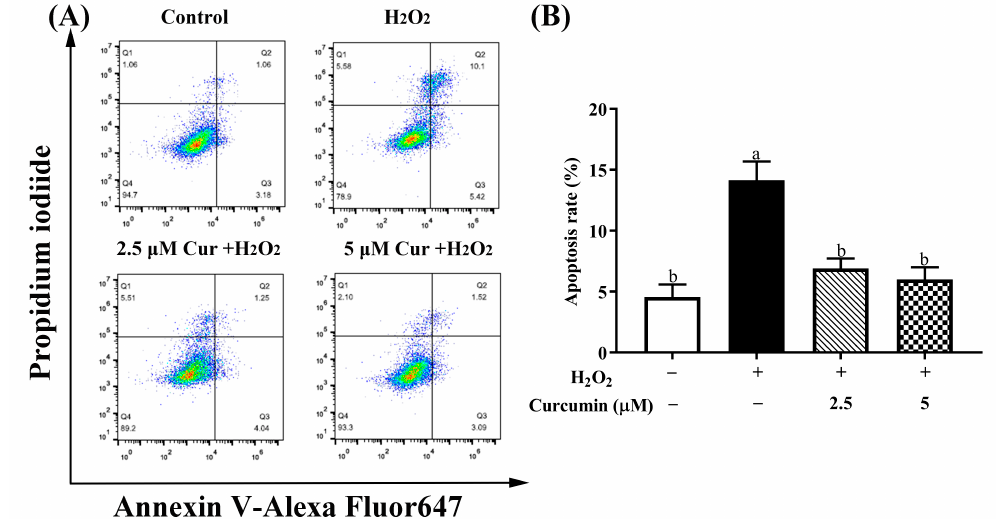
Figure 3. Effects of curcumin on H 2 O 2 -induced apoptosis in HTR8/SVneo cells measured by flow cytometry. ( A ) Control, the control group; H 2 O 2 , H 2 O 2 treatment group; 2.5 μ M Cur + H 2 O 2 , 2.5 μ M